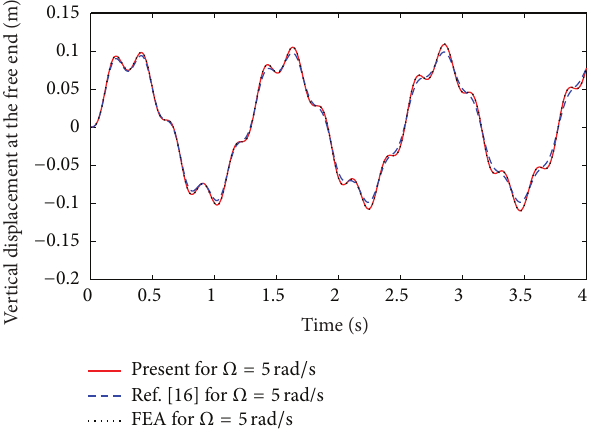
Figure 3: Time history of the free-end vertical displacement for a cantilevered beam carrying three mass-spring-damper systems for a forcing frequency Ω = 5 rad/s, 𝑘 = 0.1 N/m, 𝑇 = 0 , 𝑀 𝑑 = 0.1 kg, = 0 kg, 𝑐 = 0.1 Ns/m, and 𝐿 = 0.1 , 0.5, 0.9 𝑀 𝑐 𝑑 1;2;3